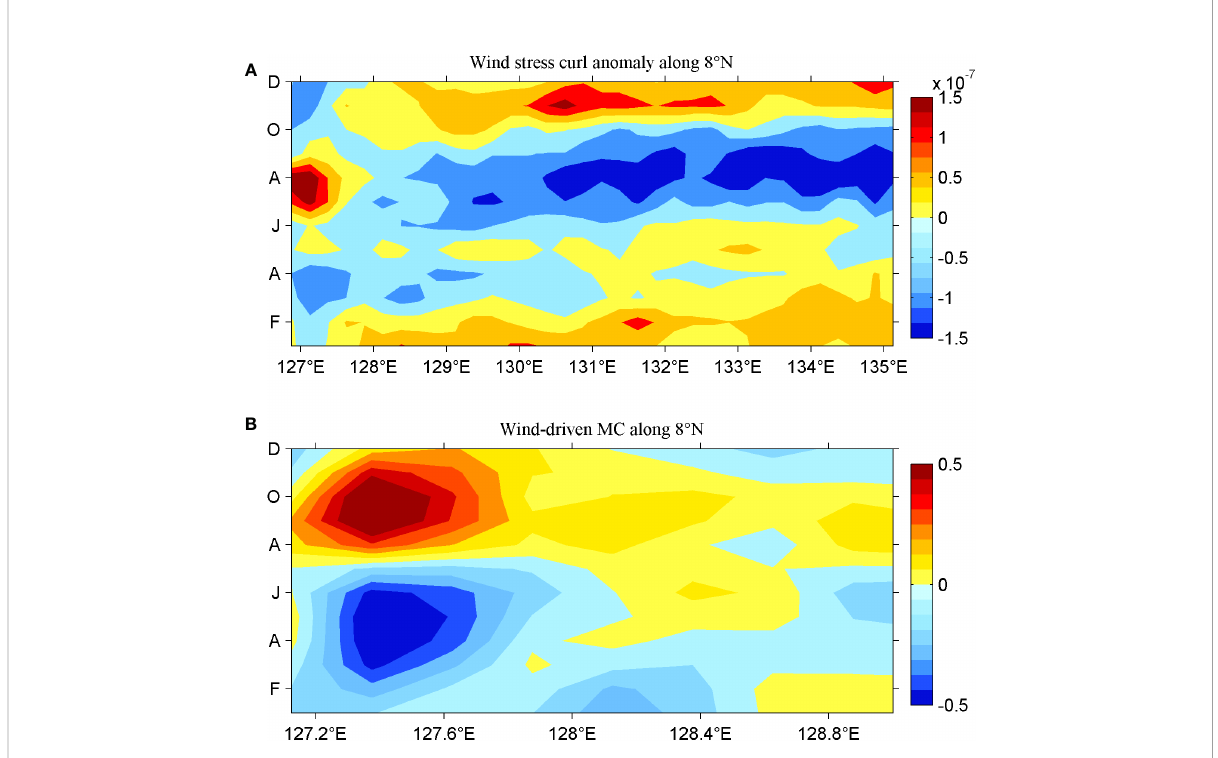
FIGURE 11 (A) Longitude – time diagram of seasonal wind stress curl anomaly along 8°N based on QuikSCAT products (1999 – 2009) (units are 10 − 7 N m − 3 ), and (B) associated longitude – time diagram of seasonal wind-driven MC along 8°N (units are